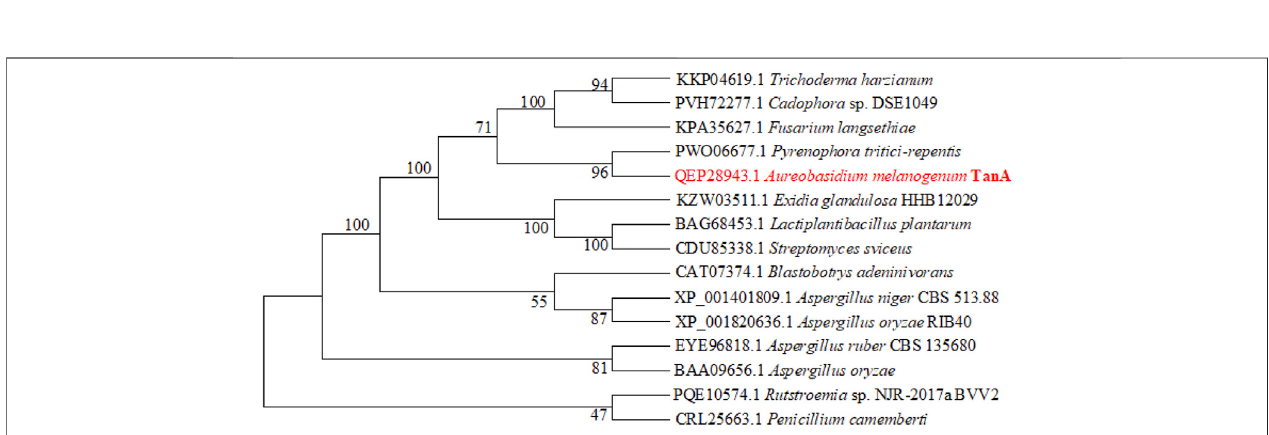
FIGURE 2 | The phylogenetic tree constructed according to the sequences of TanA and other tannases. TanA researched in this study is in red.